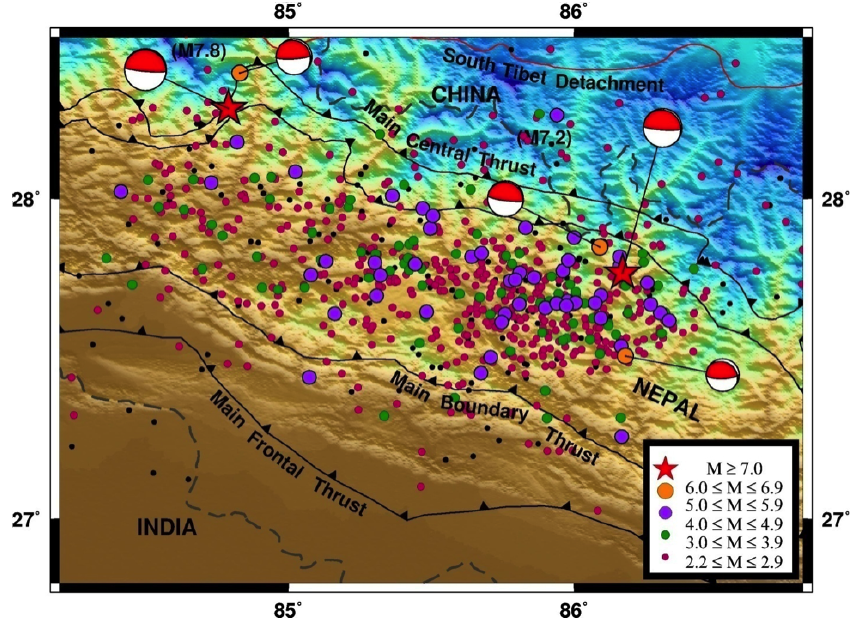
Figure 1. Tectonic map of Nepal and adjoining region drawn with the epicentral locations of aftershock sequences of Nepal earthquake dur- ing the period April 25 - October 31, 2015. Well determined focal mechanism solutions of the five largest earthquakes (listed in Table 2) are also shown with red color beach ball in the map. Stars show the epicenter of first ( M quake sequence that occurred on April 25, 2015, and May 12, 2015, respectively.